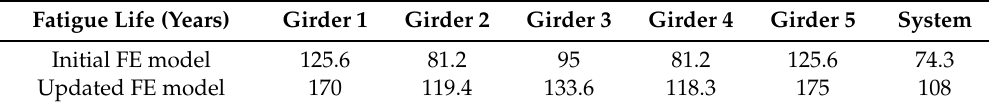
Table 4. Fatigue life estimated from initial and updated FE models.